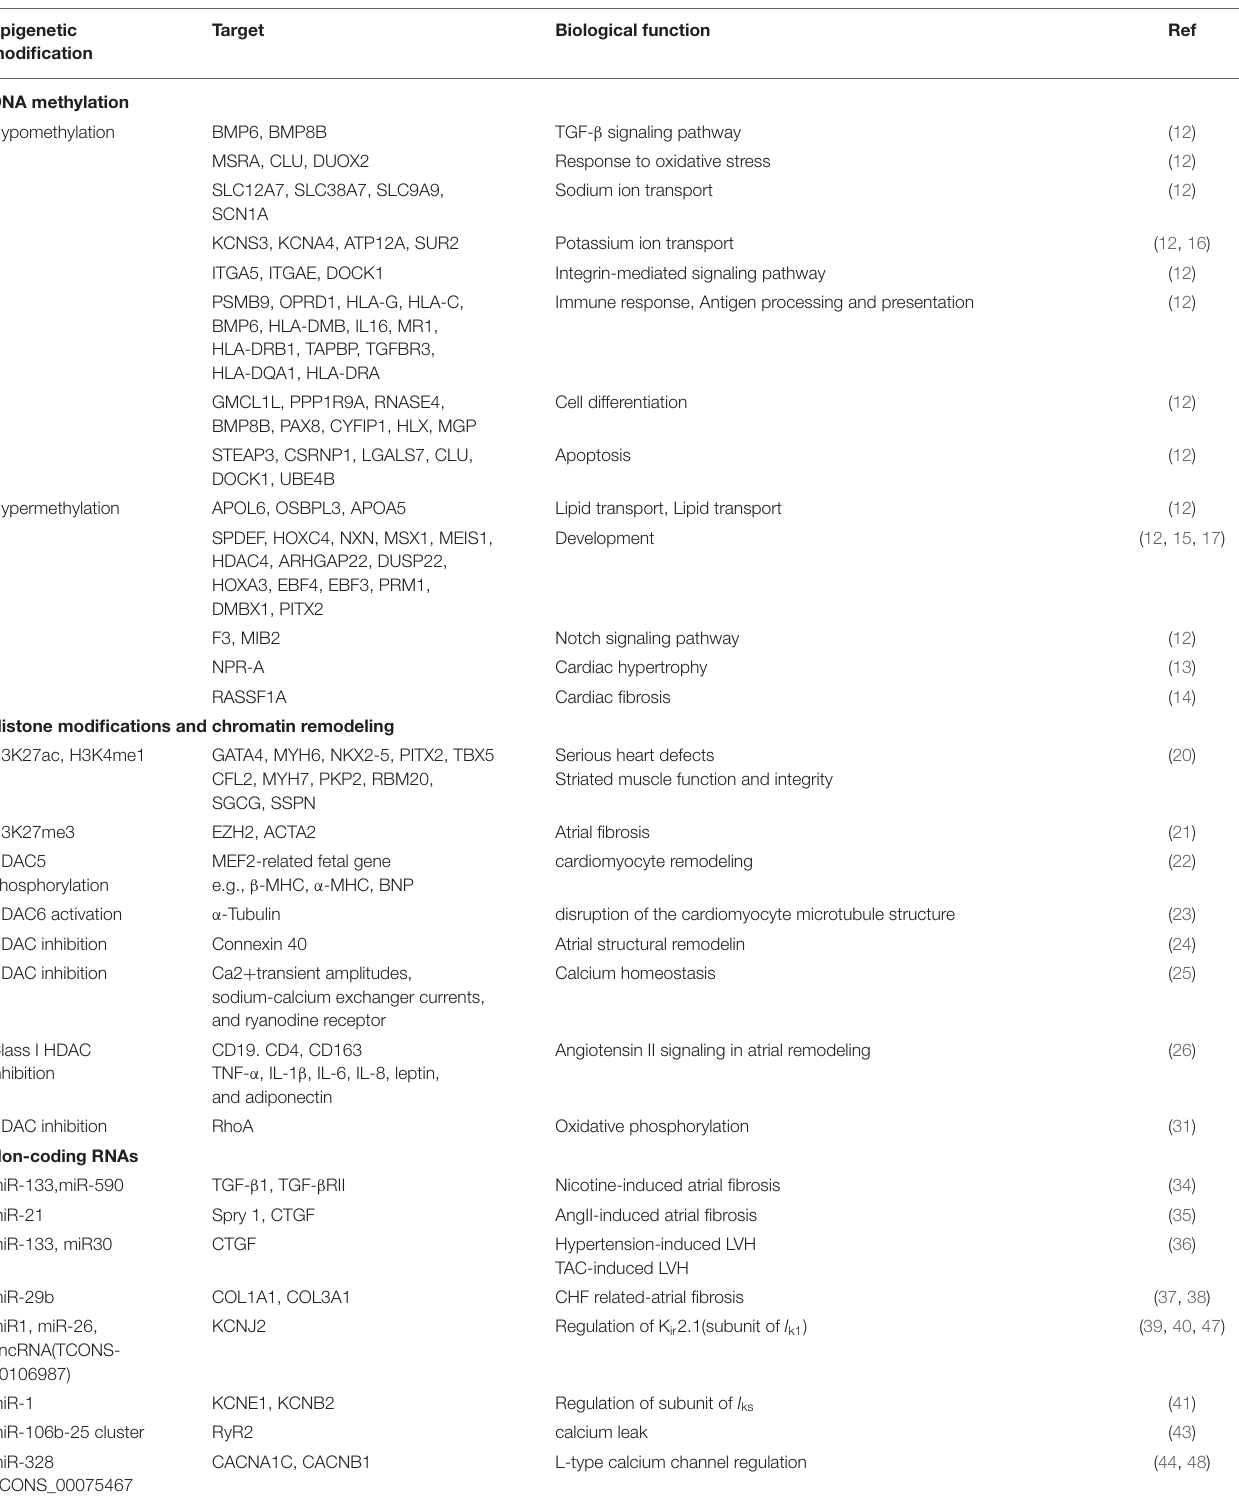
TABLE 2 | Target of epigenetic modification in